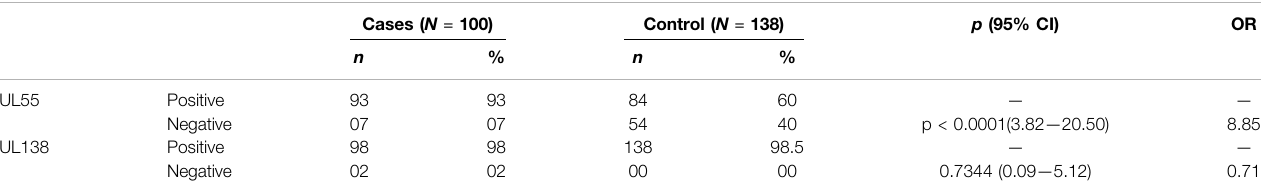
TABLE 2 | Prevalence of HCMV in blood samples collected from CRC patients and controls. Cases ( N = 100)